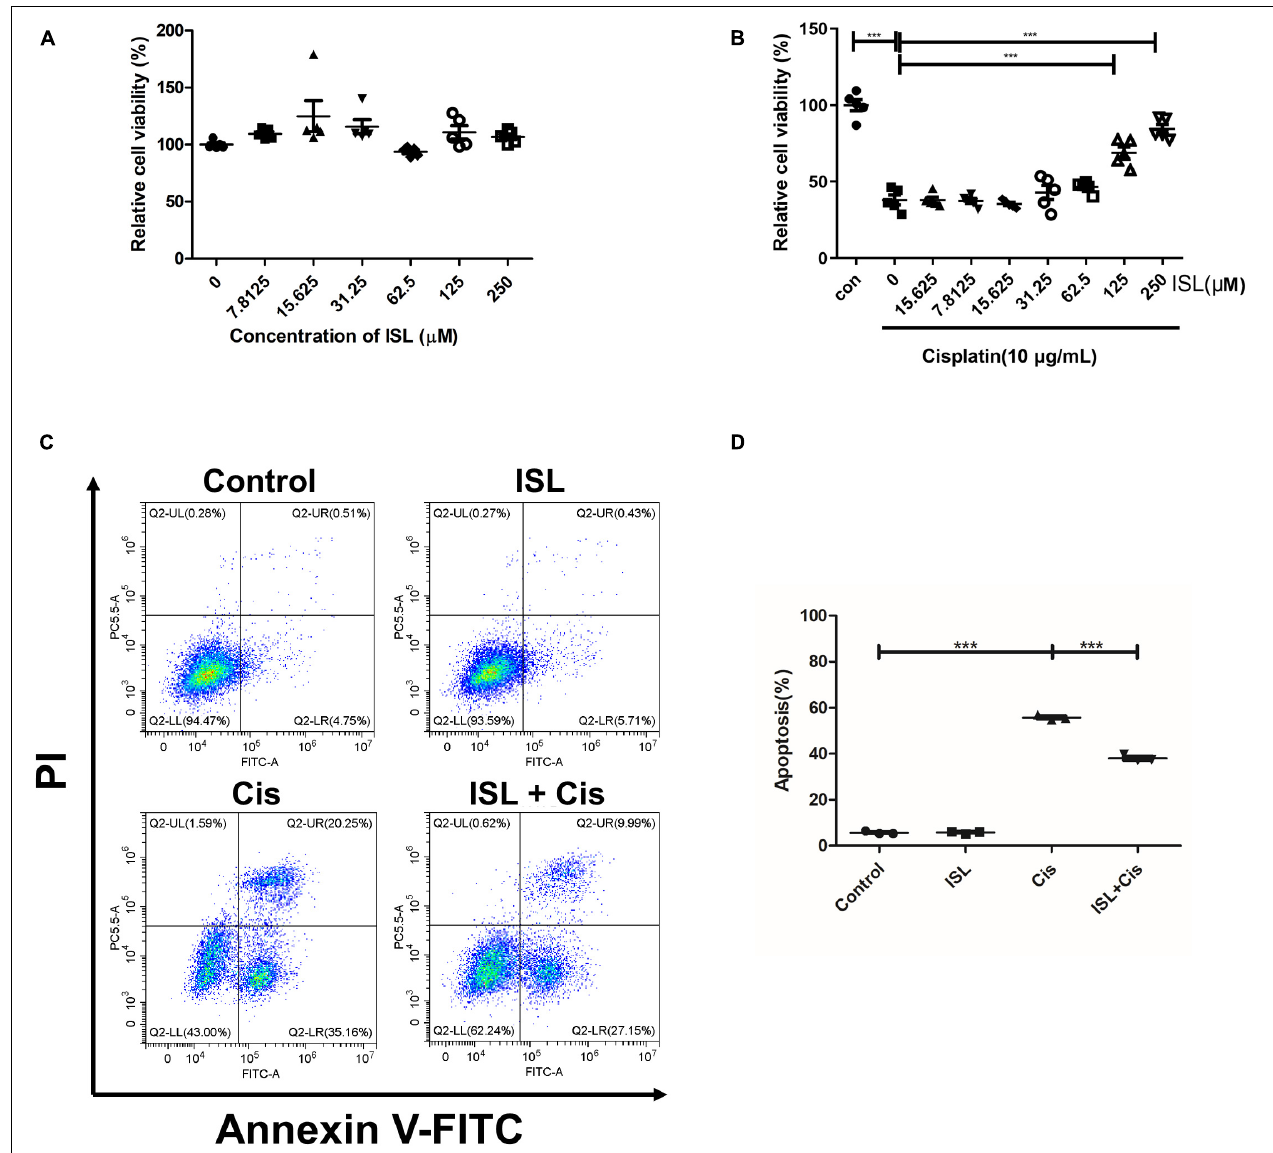
FIGURE 4 | ISL protected HK2 cells against cisplatin-induced injury. (A) CCK-8 assay was performed to analysis the viability of HK2 cells administered increasing concentrations of ISL from 7.8125 to 250 µ M for 24 h ( n = 5 per group). (B) CCK-8 assay was performed to analysis the viability of HK2 cells pretreated with increasing concentrations of ISL from 7.8125 to 250 µ M for 6–8 h followed by 10 µ g/mL cisplatin stimulation for 24 h ( n = 5 per group). (C) Representative flow cytometry analysis of Annexin V and PI staining. HK2 cells were pretreated with 125 µ M ISL for 6–8 h followed by stimulation with 10 µ g/mL cisplatin for 24 h. (D) Quantification of flow cytometry ( n = 3 per group). The data presented is expressed as mean ± SD of each group. *** p < 0.001 (ANOVA with multiple